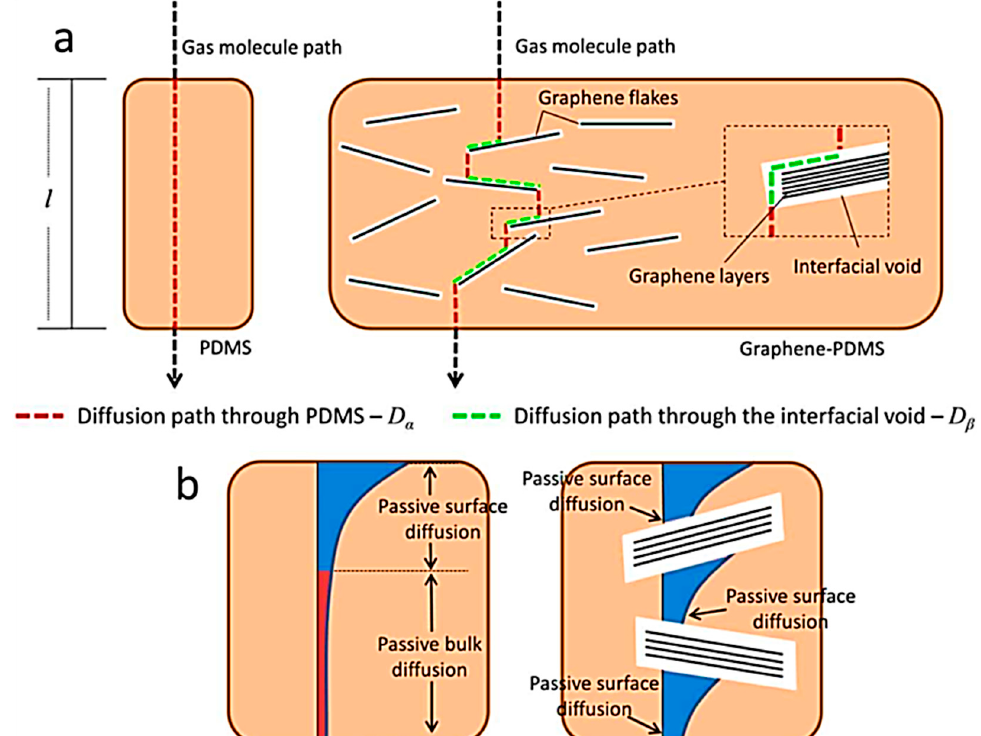
Figure 9. ( a ) Schematic of diffusion paths for PDMS and PDMS/graphene nanocomposites. The total path length for pristine PDMS membrane is l . In PDMS/graphene nanocomposite membrane, the diffusion path ( D α ) is shown in red and the diffusion path through interfacial void ( D β ) is shown in green; ( b ) a schematic depicting the difference between passive surface and bulk diffusion of gas molecules in pristine PDMS and PDMS/graphene nanocomposite membranes [113]. PDMS = poly(dimethyl siloxane). Reproduced with permission from ACS.